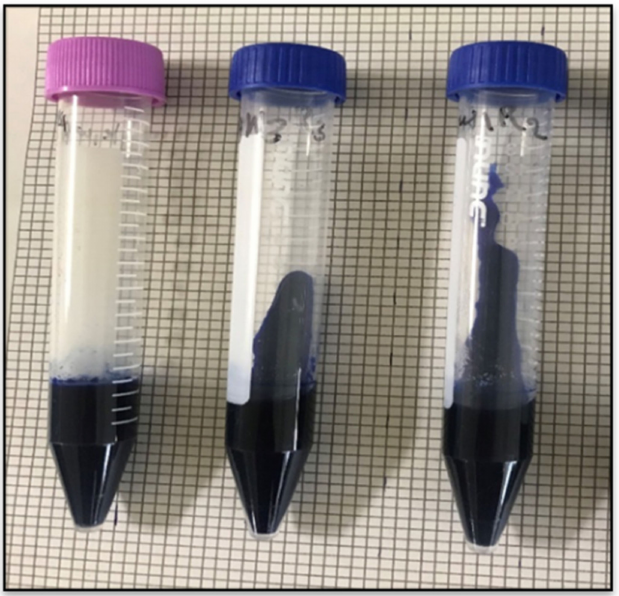
Figure 2. Gel consistency of the